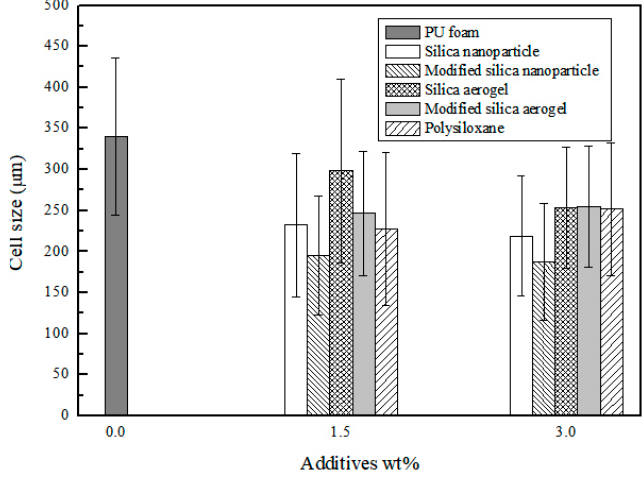
Figure 6. Distribution of mean cell size of PU and PU composite foams with three different methods. The error bars correspond to the standard deviation of cell size in the foams.